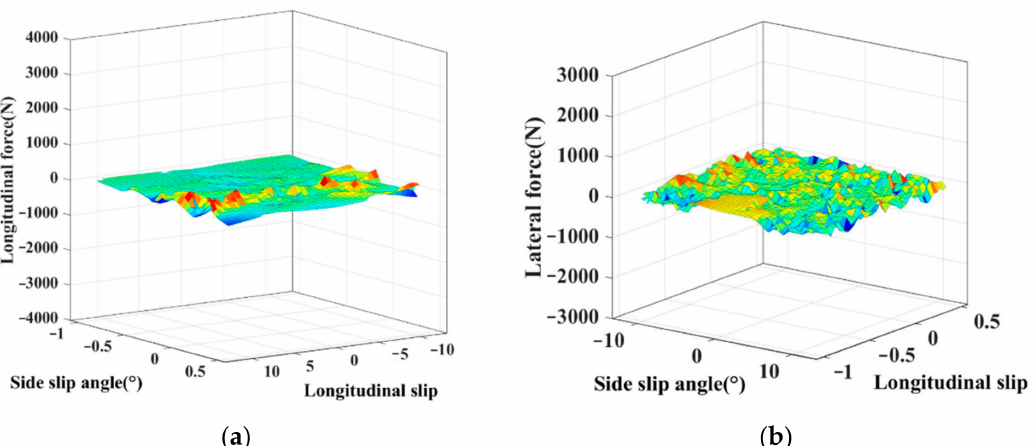
Figure 5. ( a ) Tire longitudinal force error between the PWA model and the experimental data; ( b ) Tire lateral force error between the PWA model and the experimental